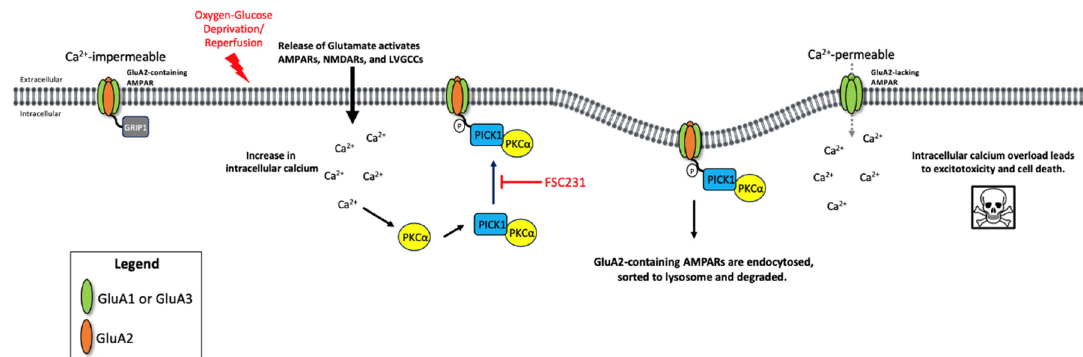
Figure 7. Potential mechanism of FSC231 treatment following OGD/R. Under normal physiologic conditions, AMPARs in the hippocampus are GluA2-containing Ca 2+ -impermeable receptors. GRIP1 is a scaffold protein that aids in tethering GluA2-containing AMPARs to the cell membrane. Under pathologic OGD/R conditions, there is a massive release of neurotransmitters, including glutamate, which activates AMPARs and subsequently activates NMDARs and L -type voltage- gated calcium channels. An increase in intracellular Ca 2+ activates PKC α binding to PICK1, which translocates to the plasma membrane. PICK1 binds to GluA2, GluA2 is phosphorylated by PKC α , and is subsequently endocytosed and degraded. There is a subsequent increase in GluA2-lacking Ca 2+ -permeable AMPARs. This leads to intracellular calcium overload, resulting in excitotoxicity and cell death. FSC231 blocks the interaction of GluA2–PICK1, prevents the GluA2 AMPAR subunit from being degraded, and acts in a neuroprotective manner.